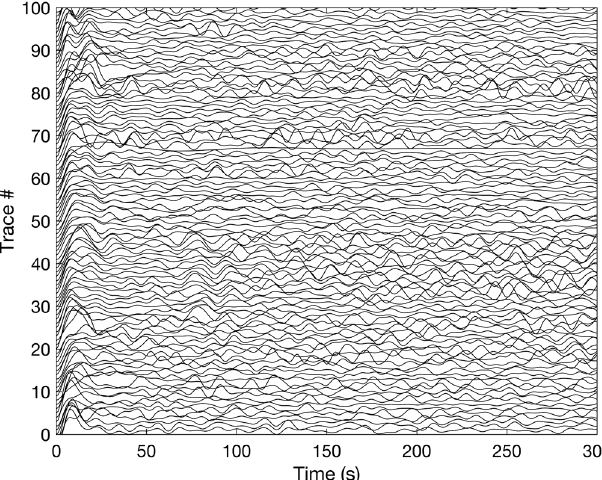
FIG. 13. Raw S-wave seismic wave amplitudes: The first 100 of 1192 traces from the USArray between 96- and 97-degree epicentral distance.